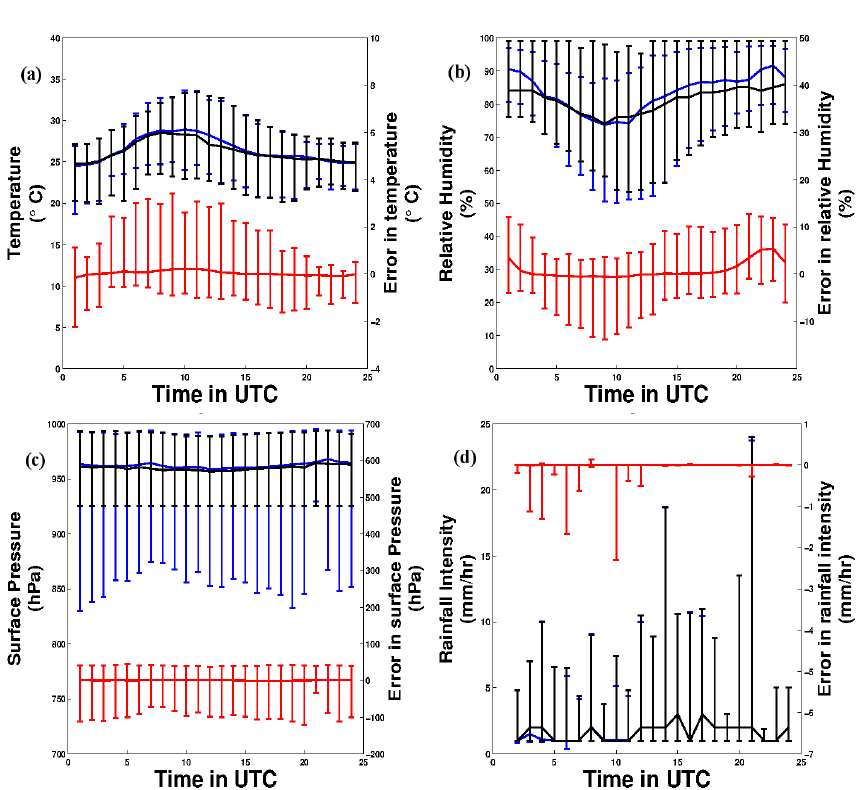
Figure 7. Comparison of automatic weather station fields and WRF-simulated temperature, relative humidity, pressure, and rainfall intensity, using the best configuration for 3 August 2012. The black line denotes the observation, the blue line denotes the simulated value, and the red line denotes the error between them. The solid lines are corresponding 0.5 quantiles, and spreads are 0.1 and 0.9 quantiles of the geographical